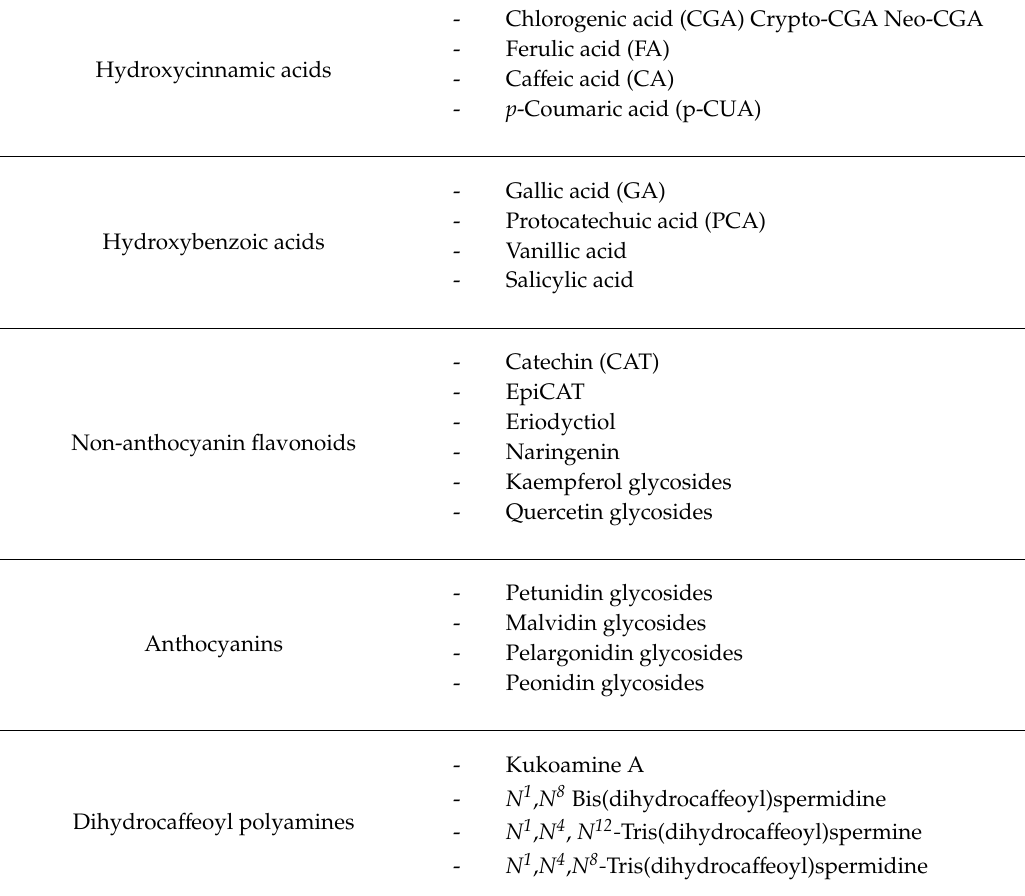
Table 2. Qualitative profile of phenolic compounds in Solanum tuberosum (Adapted from: Akyol et al., 2016